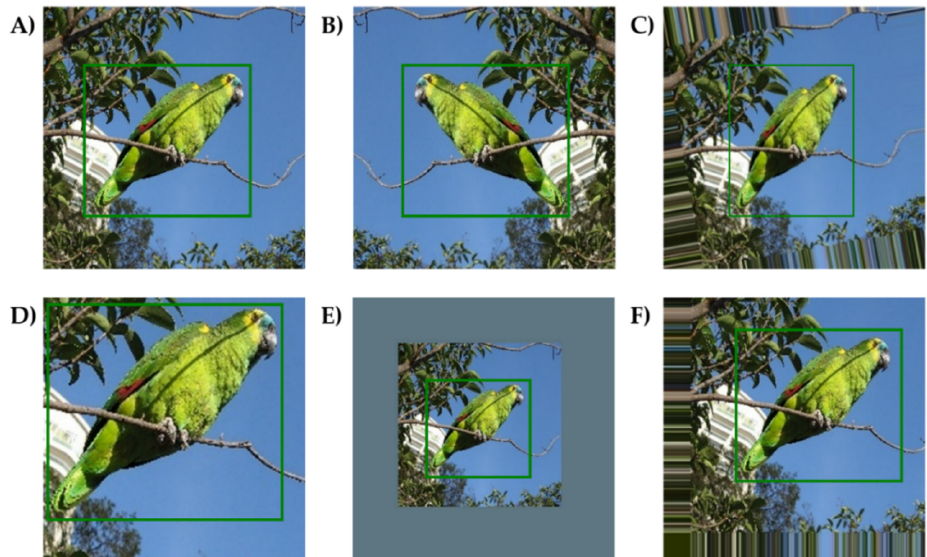
Figure 1. Representative images of Amazona aestiva after data augmentation. The green boxes in the images represent the ground-truth bounding boxes. ( A ) Initial image, ( B ) Horizontal flipped image, ( C ) Rotated image, ( D ) Zoomed-in image, ( E ) Zoomed-out image, and ( F ) Translated image. Photo credit: Mauro Halpern.